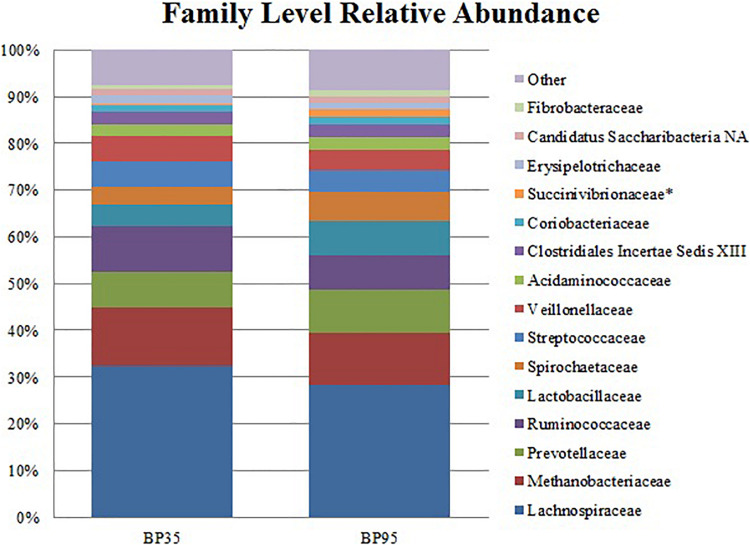
Stack plot comparing the differences, between diets, in the relative abundances of the fifteen most abundant microbes at the family level. Asterisk (∗) signifies families with a significantly different relative abundance between diets. BP35 = Concentrate formulated with 35% by-product. BP95 = Concentrate formulated with 95% by-product.